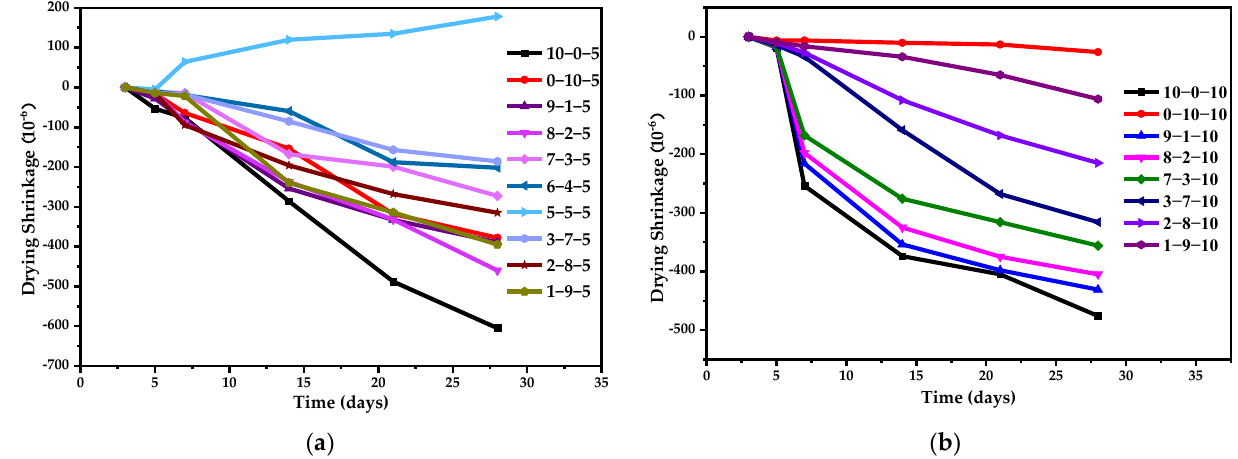
Materials 2021 , 14 , x FOR PEER REVIEW